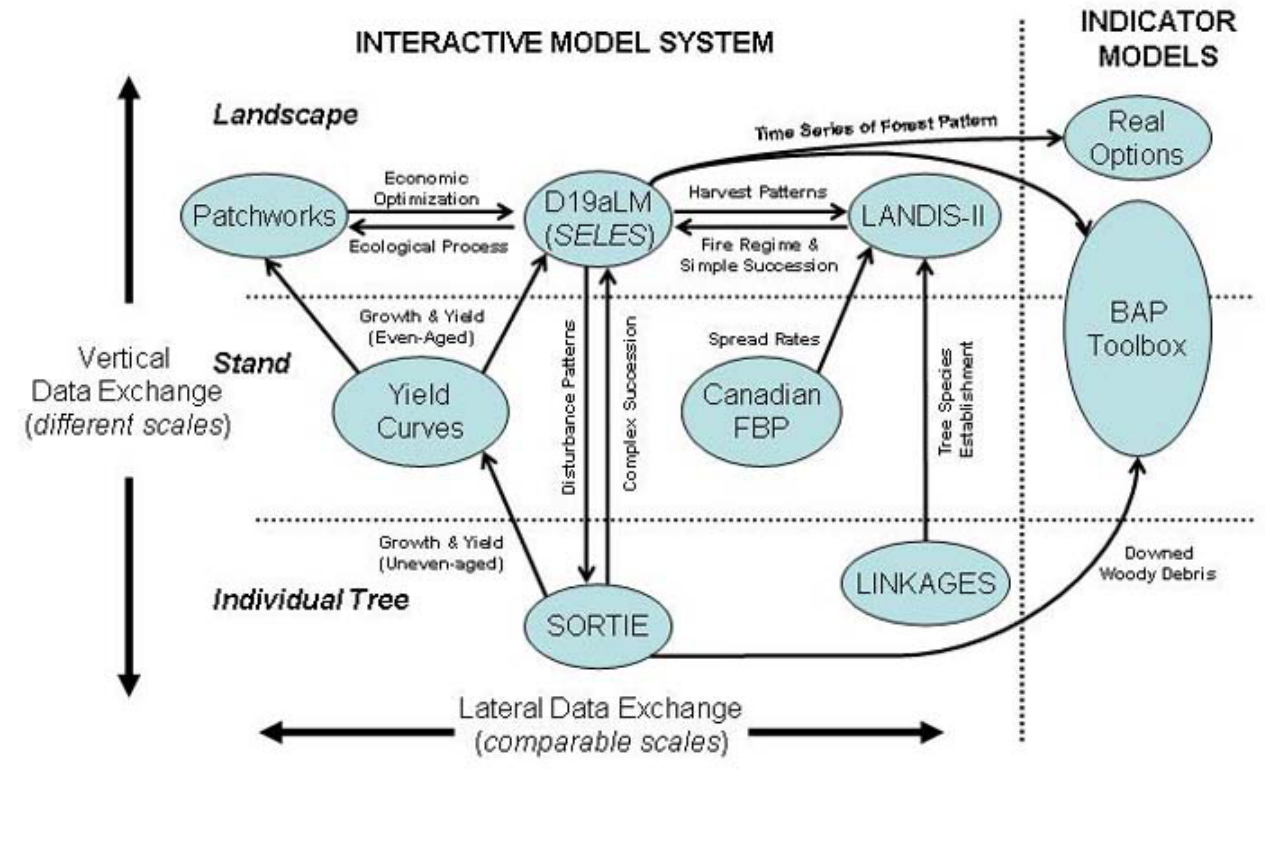
Fig. 5. Relationship diagram showing information flow between different models in the toolkit for the Labrador District 19A system, based on the conceptual diagram (Figure 4). Information exchange between models is organized in vertical (cross-scale) and horizontal (same scale) dimensions. Models are briefly summarized in Table 1, and online readers can click on a specific model “bubble” to access additional model detail and illustrations of information exchange from the